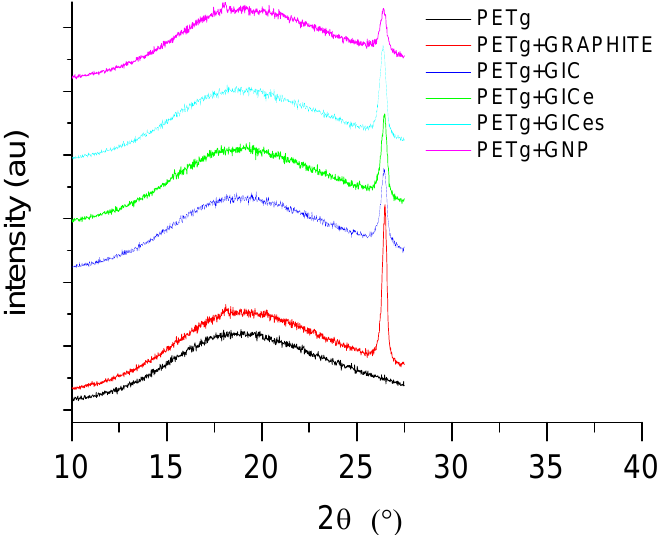
Figure 5. XRD traces of poly-ethylene-terephthalate (PETg) nanocomposites.